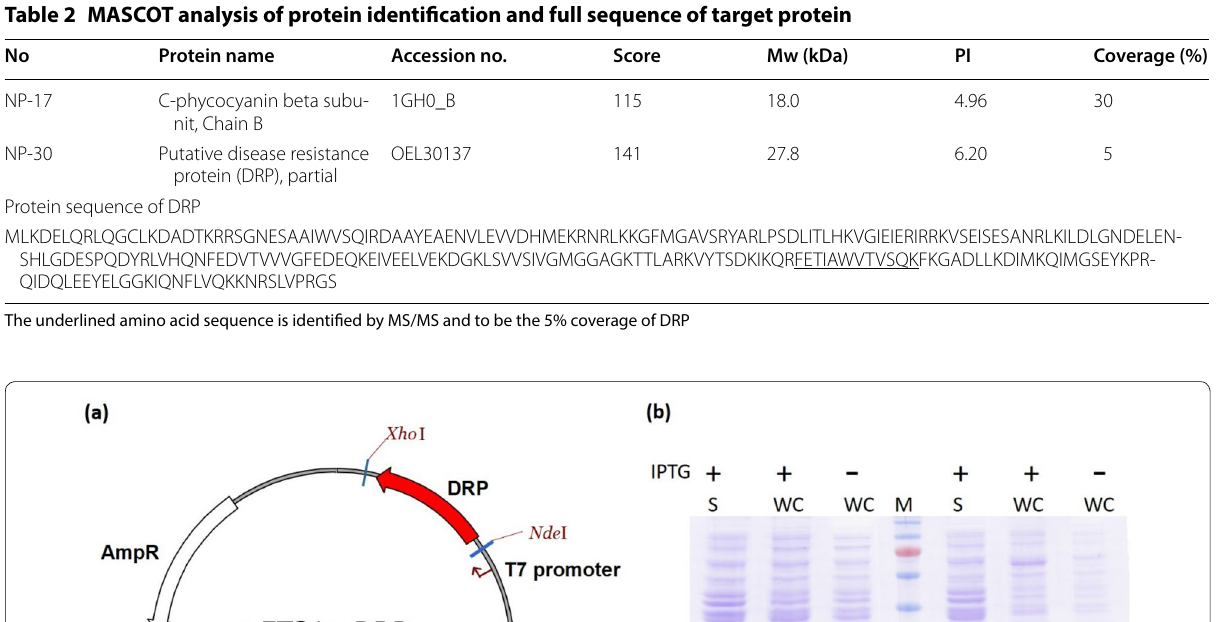
Table 2 MASCOT analysis of protein identification and full sequence of target protein No